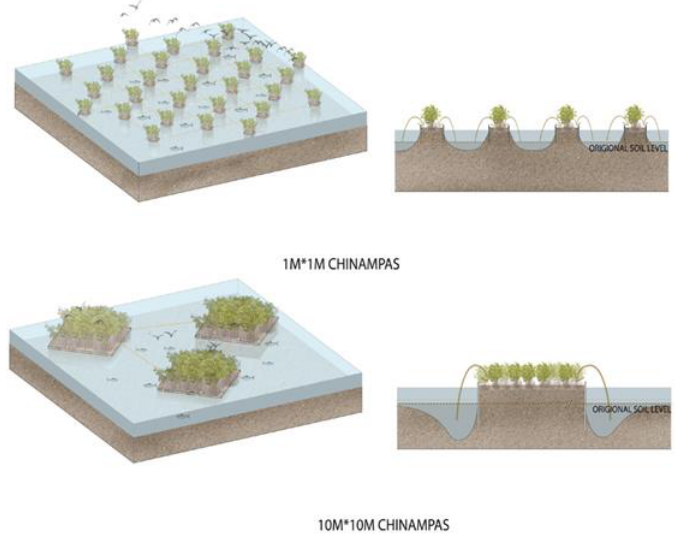
Figure A3. System of Chinampas.